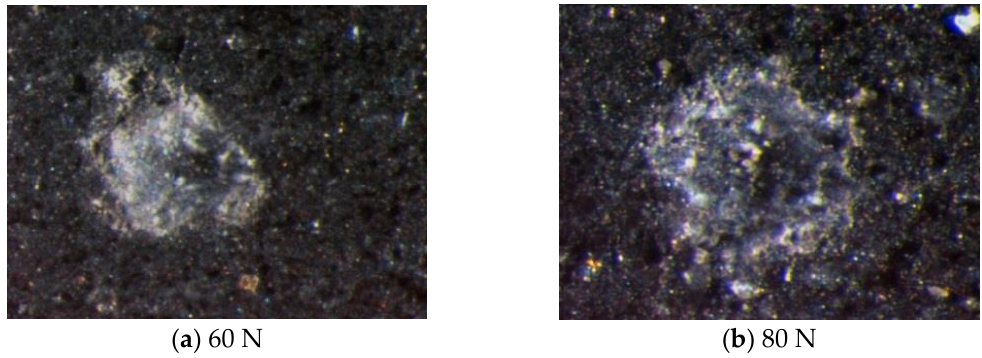
Figure 7. Typical micro-indentation images of shale by using Vickers indenter.